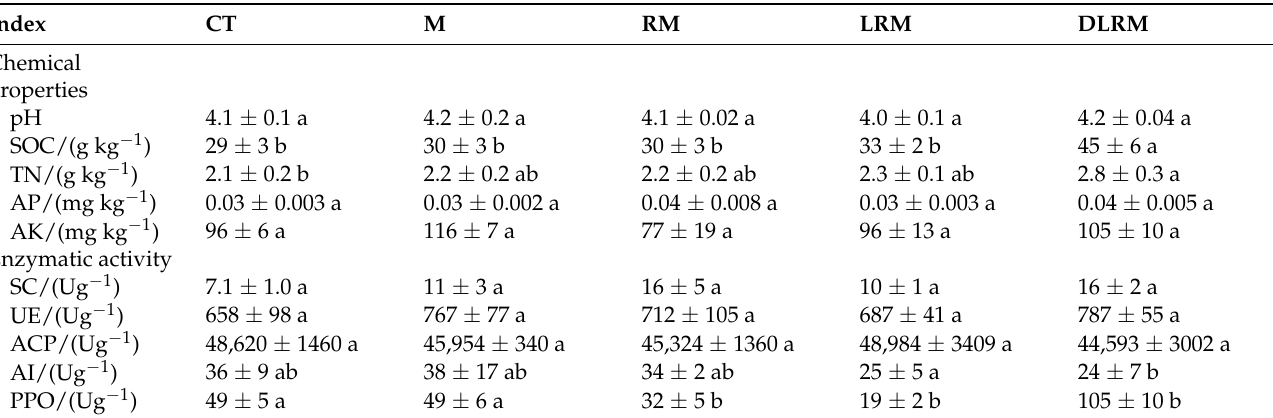
Table 2. Soil chemical properties and enzymatic activity of different